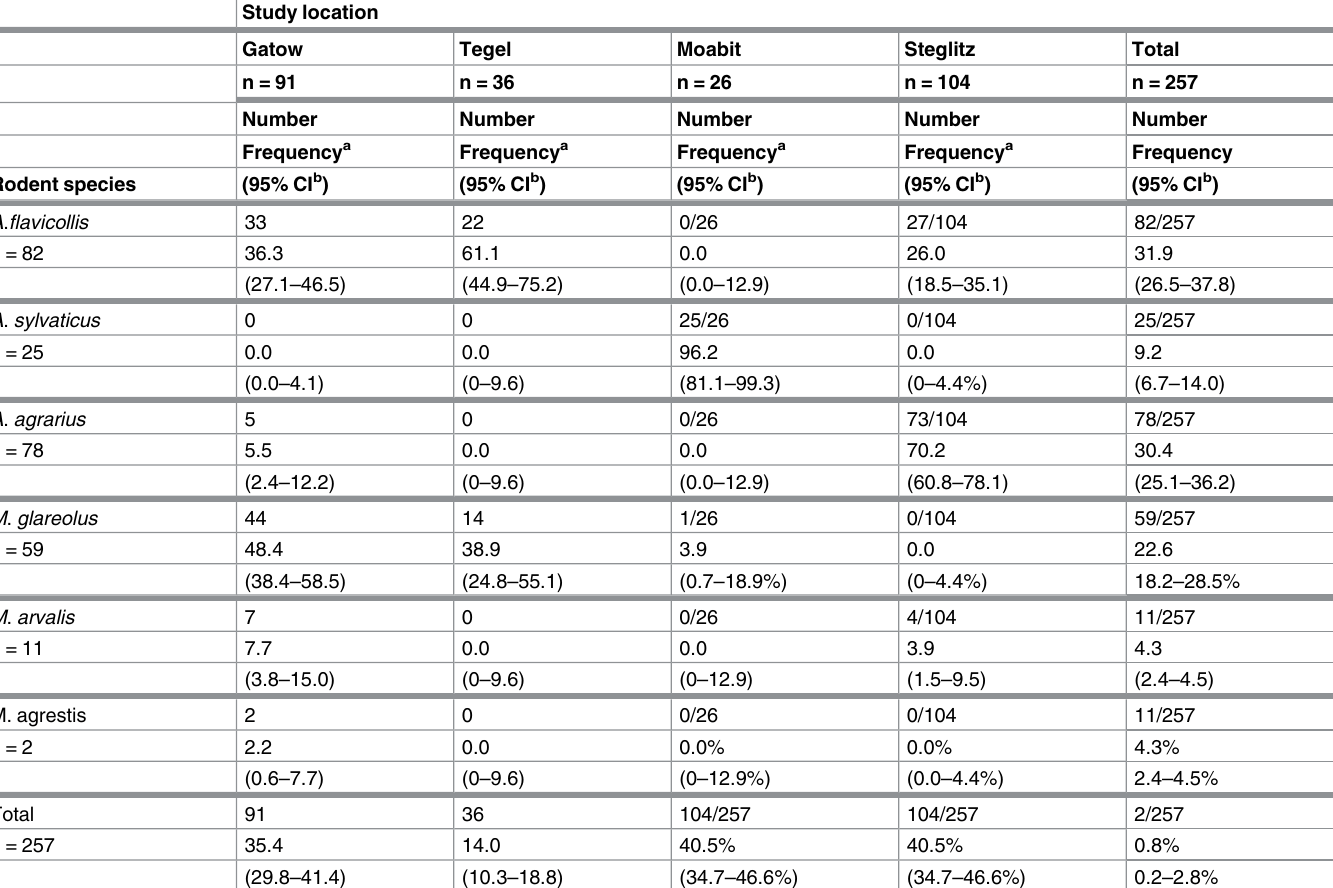
Table 1. Rodent species trapped at the different study sites and included in the